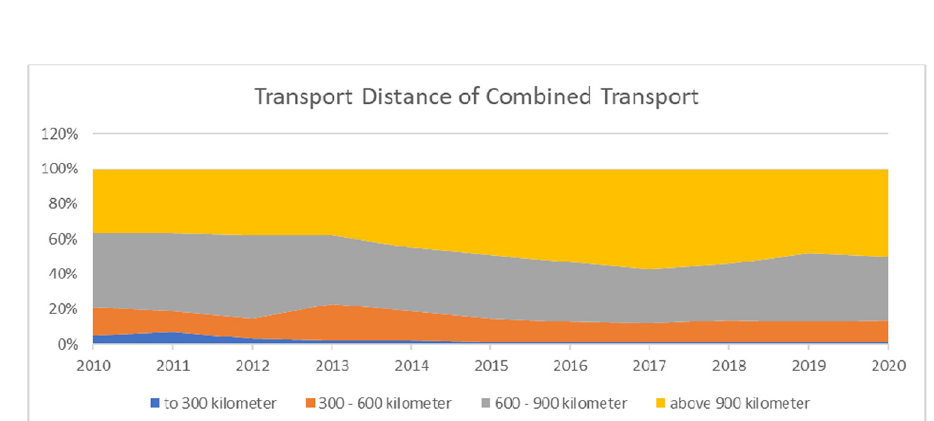
Figure 5: Transport distance of combined transport. Source: ref. [ 14 ]